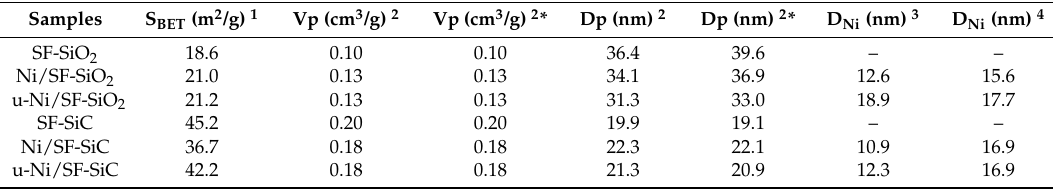
Table 2. Physical and chemical properties of the catalysts and